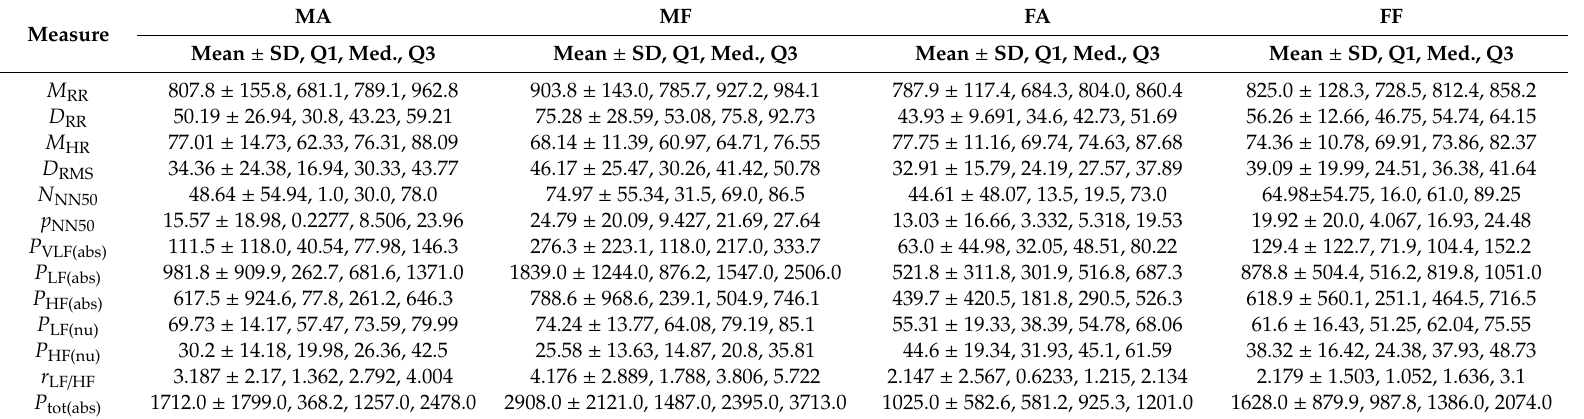
Table 5. Descriptive statistics of HRV time and frequency domain measures of drivers with di ff erent mental states and of di ff erent